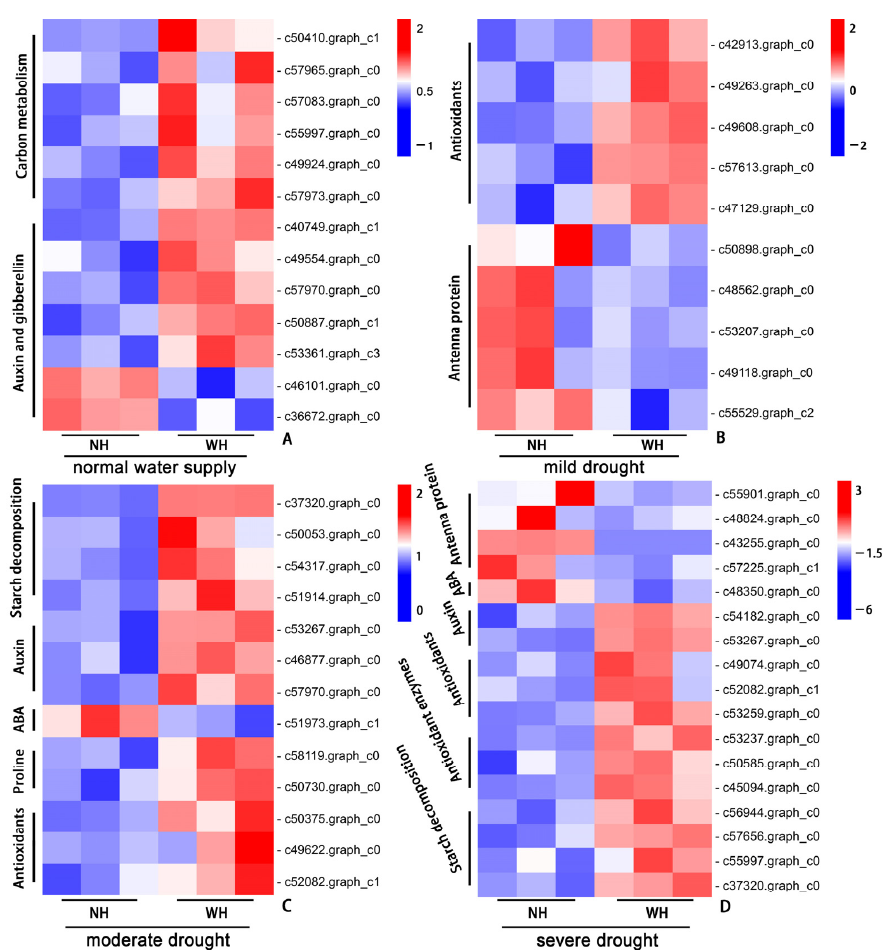
Figure 7. Heatmap of gene expression. Gene expression between grown without host (NH) and grown with host (WH) under normal water supply ( A ), mild drought stress ( B ), moderate drought stress ( C ), and severe drought stress ( D )